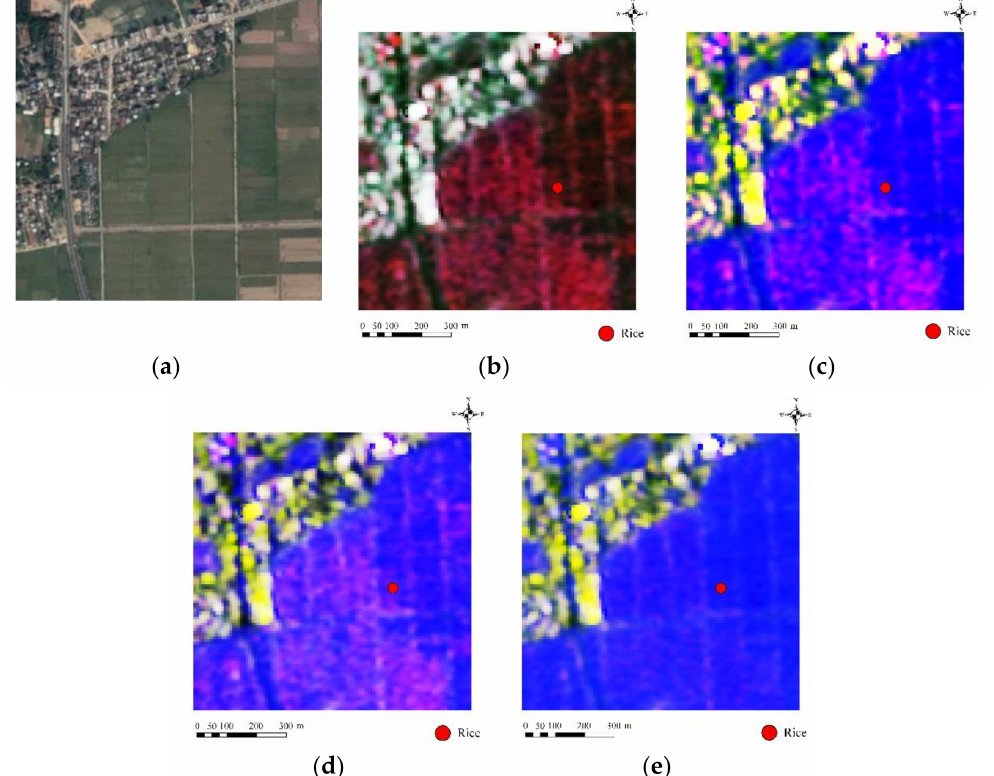
Figure 7. Examples of rice in the optical image and the false color composite images with different combinations of statistical parameters. ( a ) The Google image of rice area; ( b ) R: maximum G: minimum B: average; ( c ) R: maximum G: minimum B: variance; ( d ) R: maximum G: average B: variance; ( e ) R: average G: minimum B: